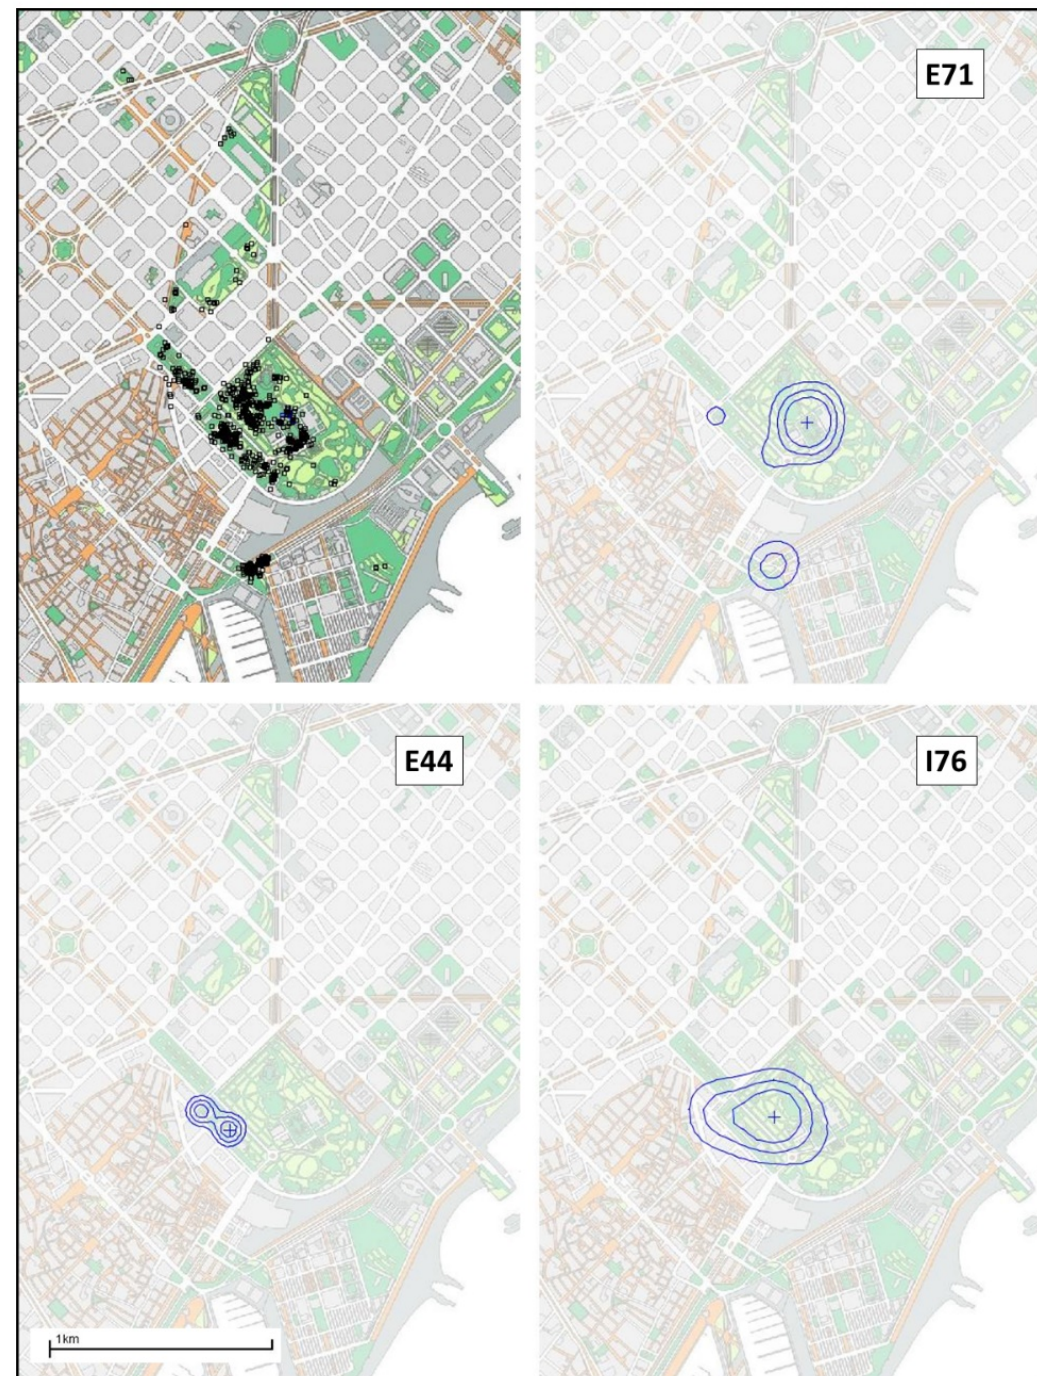
Figure 2. Study area displaying all the visual observations of the 73 marked monk parakeets and three examples of home-range area (kernel method). Home ranges display 50, 75, and 95% contours. The home range of individual I76 is compact, while that of E44 and E71 is multinuclear, with two and three activity areas, respectively. The activity center, computed by Ranges 9 as the location at which the Gaussian kernel estimator indicates highest density, is marked with the sign +.